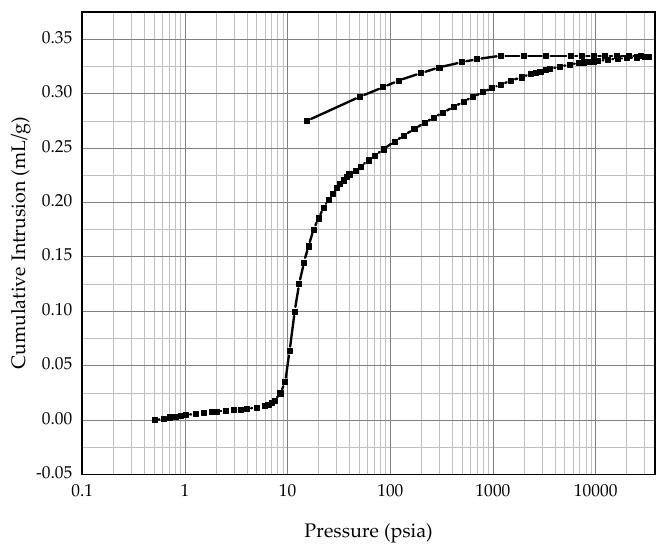
Figure 14. Mercury injection − mercury removal curve of soil sample 2.